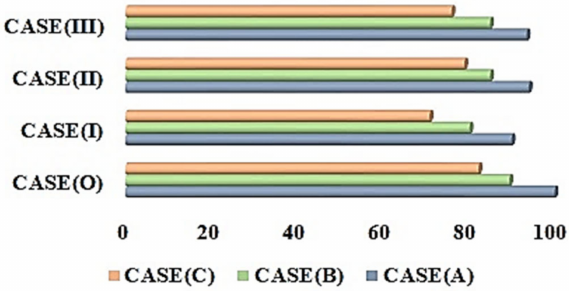
Figure 7. Comparison of operating cost of MG for different cases.